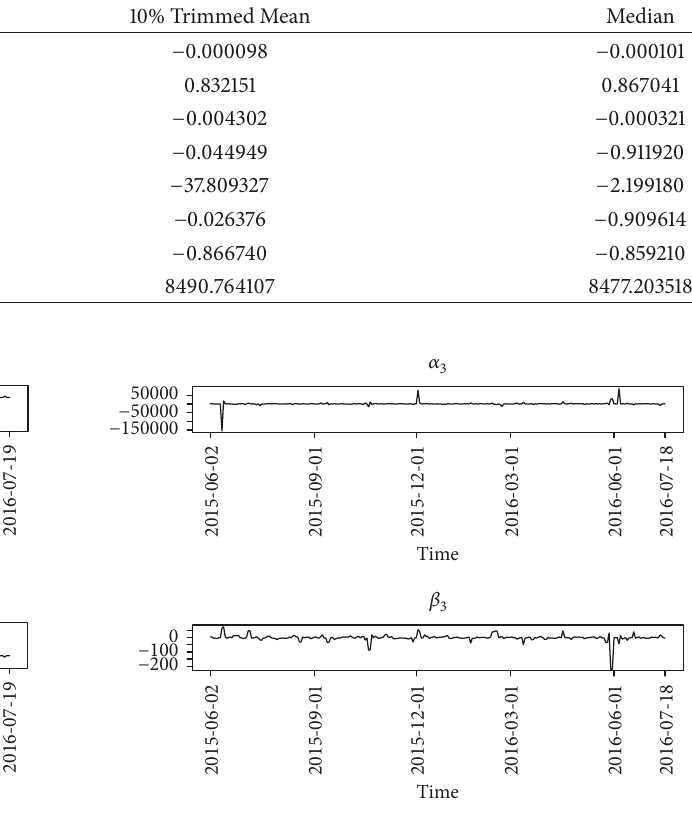
Figure 10: Time plots of model A coefficients- 𝛼 1 and 𝛽 1  2